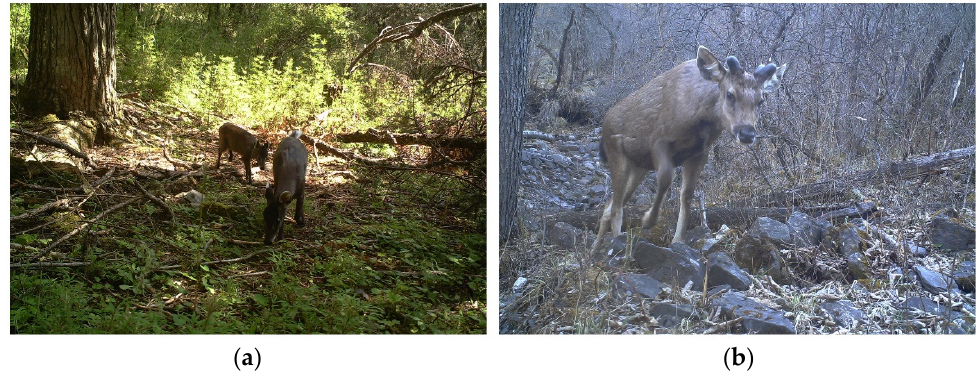
Figure 2. Photos of tufted deer ( a ) and sambar ( b ) in the Gongga Mountain National Nature Reserve, China.